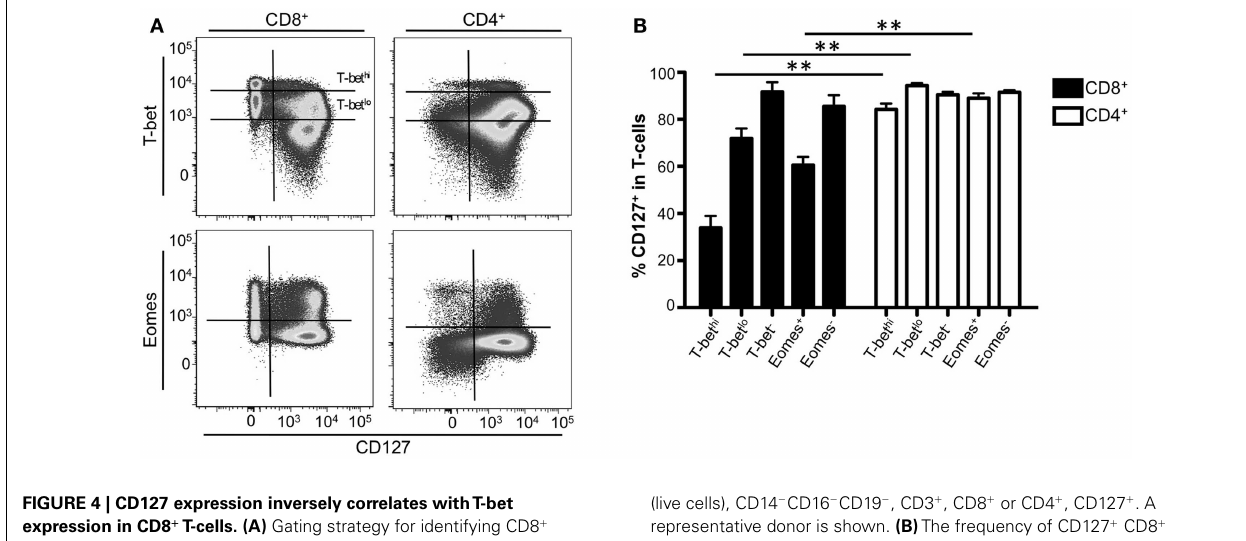
FIGURE 4 | CD127 expression inversely correlates withT-bet expression in CD8 + T-cells. (A) Gating strategy for identifying CD8 + or CD4 + CD127 + T-cell memory subsets. Flow cytometry data shown were gated as follows: singlets, lymphocytes, Aqua Blue −